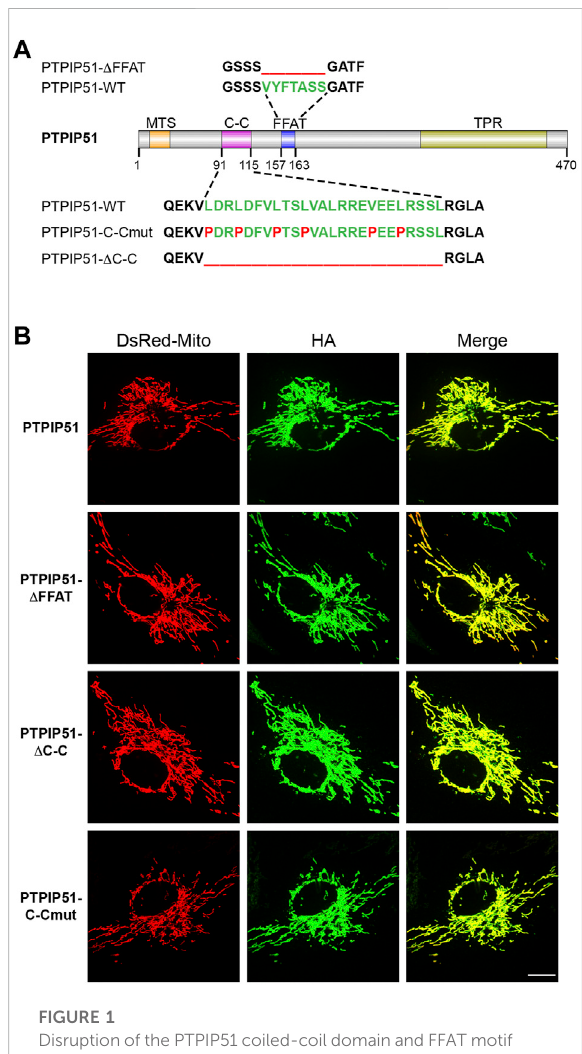
FIGURE 1 Disruption of the PTPIP51 coiled-coil domain and FFAT motif doesnotaffectPTPIP51mitochondriallocalisation. (A) structureof PTPIP51 showing the N-terminal mitochondrial targeting sequence (MTS), coiled-coil domain (C – C), FFAT motif and C-terminal tetratricopeptide repeat domain (TPR). Also shown are mutantsequencesinwhichtheFFATmotifandcoiled-coildomain were entirely deleted and in which disrupting prolines were introduced into the coiled-coil domain. (B) Mitochondrial localisation of the wild-type, FFAT and coiled-coil PTPIP51 mutants used in this study. Cells were transfected with DsRed-Mito and HA-tagged wild-type PTPIP51, PTPIP51- Δ FFAT, PTPIP51- Δ C-C, or PTPIP51-C-Cmut. Cells were immunostained for transfected PTPIP51 via the HA-tag and analysed by SIM. Scale bar = 10 μ